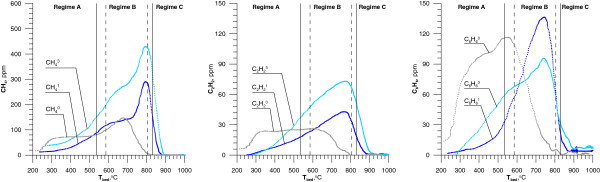
The effect of adding MCB on [C2H2], [CH4], [C6H6] in flue gases (0 - 0 ppm MCB1 - 900 ppm MCB,3 - 3650 ppm MCB). Continuous and dashed vertical lines are defined below Figure 2.